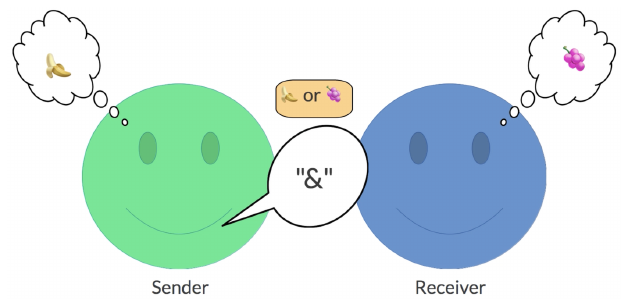
Figure A3. Screenshots of the final screen of an exemplary interaction round for the CS game. The contextual cue is presented as a disjunction of two information states, of which one is